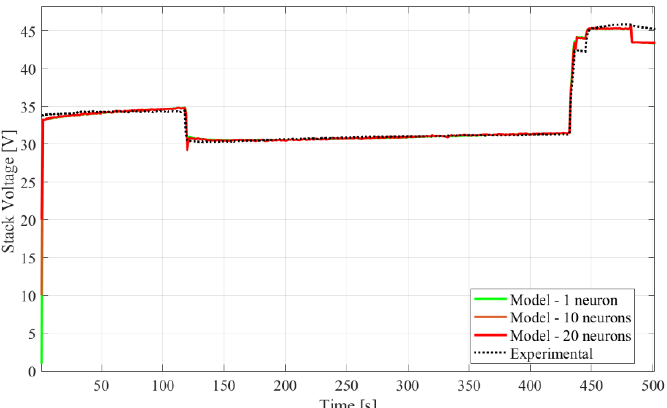
Figure 7. Experimental and model responses of the stack voltage using an ANN with the Bayesian- based algorithm.